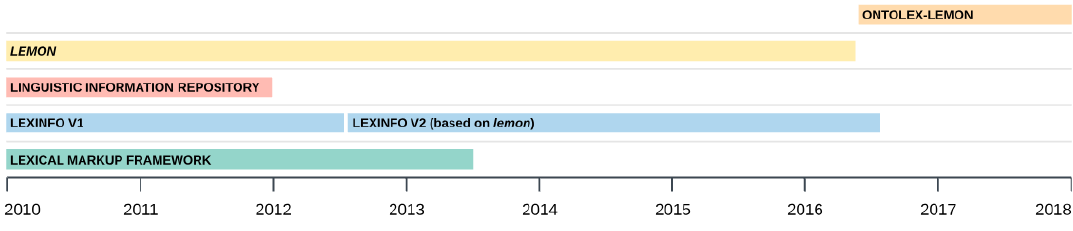
Figure 6. Timeline of the models in development.